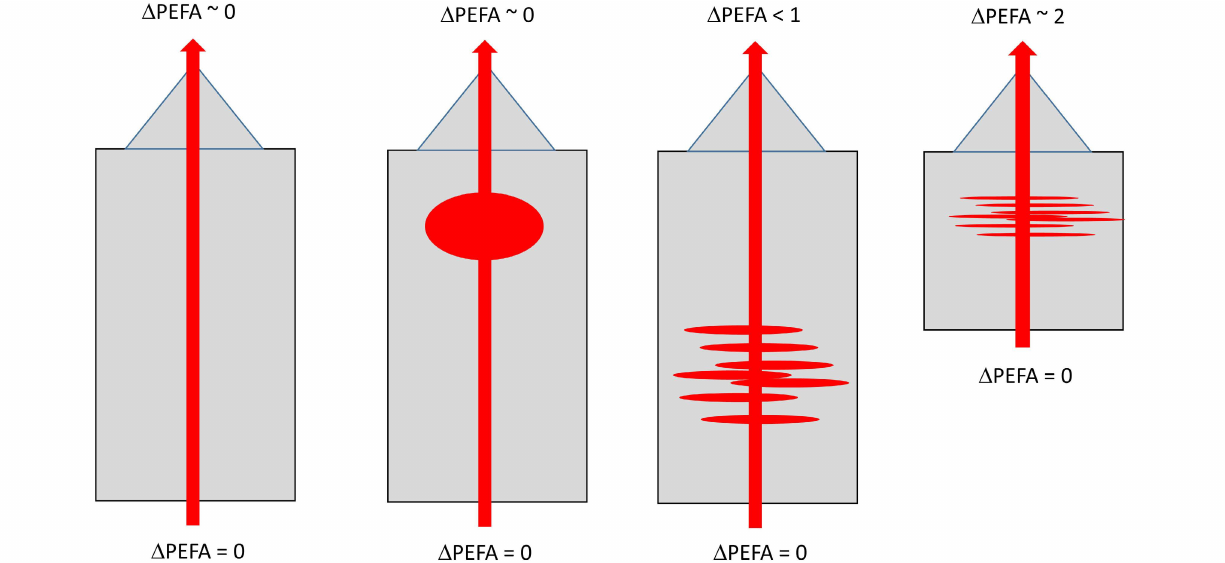
Figure 10: Cartoons depicting different types of magmatic plumbing systems and qualitative predictions on the degree of dise- quilibrium expressed in terms of Δ PEFA. We assume that Δ PEFA = 0 in the mantle melting regime due to the high temperatures and limited mobility of the melts. Once melts leave their mantle sources, they may transit to the surface in different ways. From left to right, direct transit to the surface, staging in a large crustal magma chamber, staging as sills in lower crust, and staging as sills in the upper crust. Direct transit to the surface may preserve Δ PEFA = 0 from the mantle as exemplified by komatiites, many of which are near-primary mantle-derived melts. In crustal staging, rapid cooling will lead is Δ PEFA >0 as in the case of small sills in the crust. Large magma chambers cool more slowly and would have intermediate Δ PEFA.